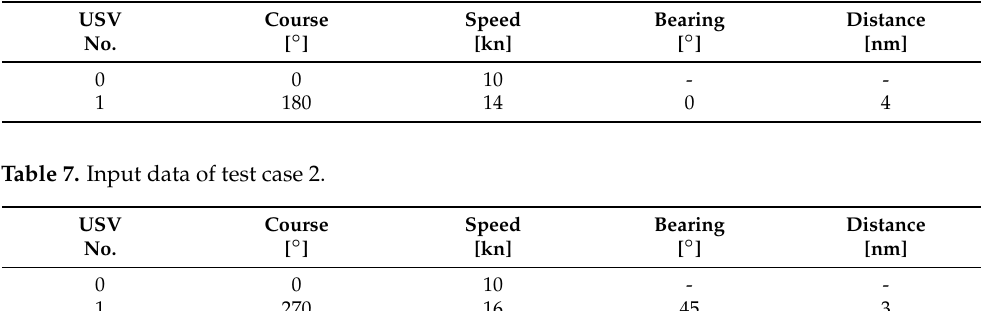
Table 6. Input data of test case 1—head-on.